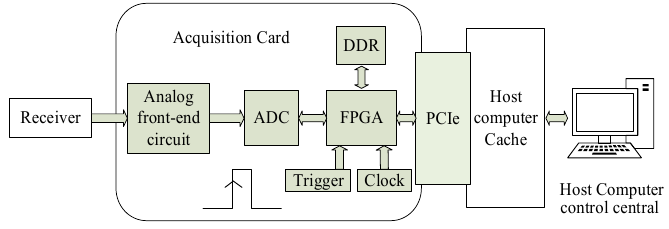
Figure 1. Block diagram of the new HFGWR acquisition system.